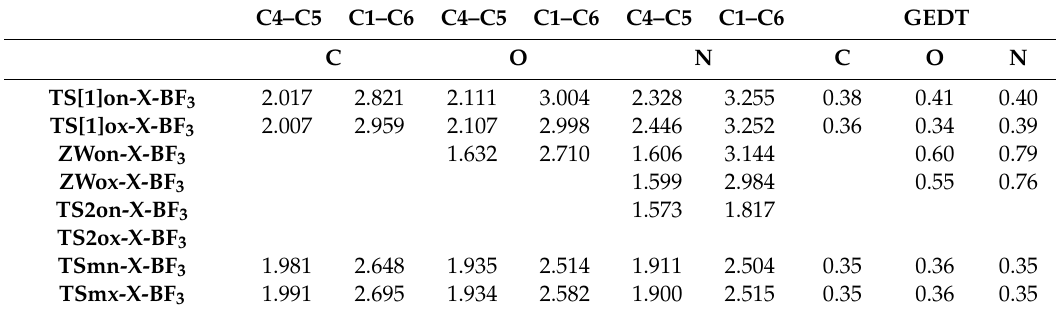
Table 5. C4–C5 and C1–C6 distances, in Angstroms, and the GEDT values, in electrons e, at the TSs and zwitterionic intermediates involved in the P-DA reactions of Cps 12–14 with complex 7-BF 3